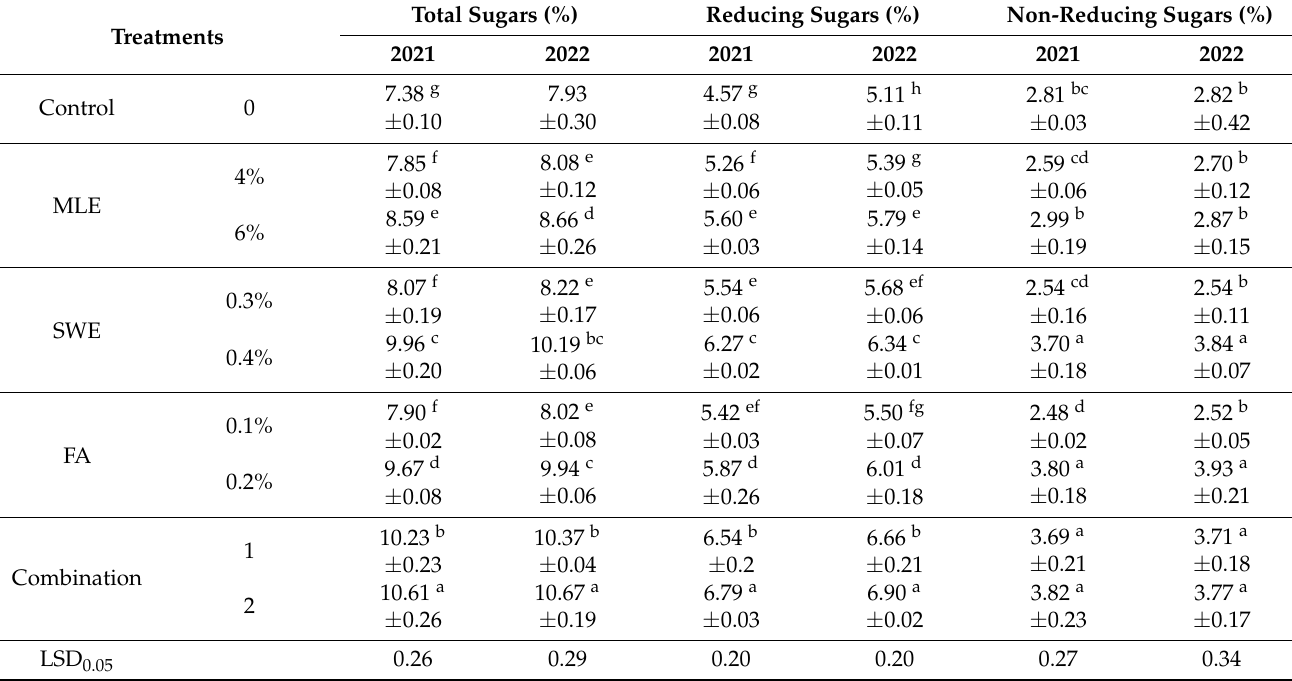
Table 6. The influence of the spraying of MLE, SWE and FA and their combinations on fruit total, reduced and non-reduced sugar percentages of apple cv. Anna during 2021 and